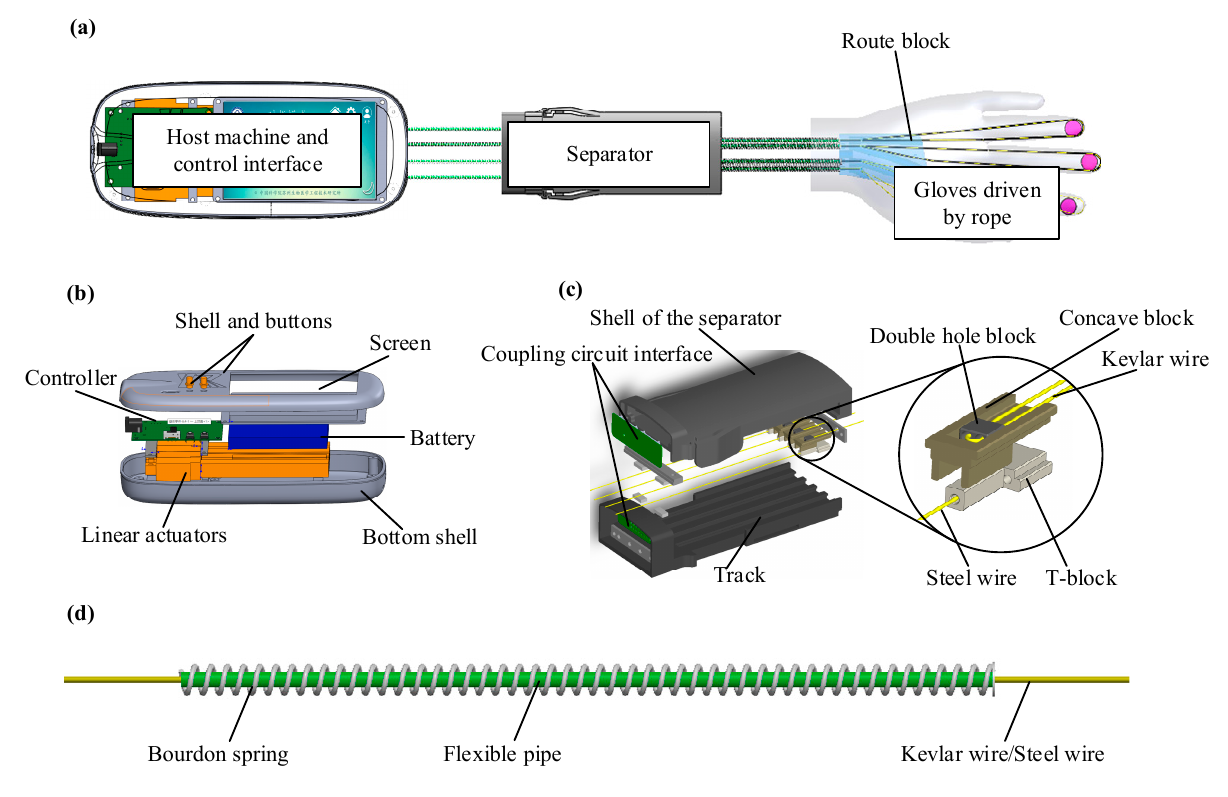
Figure 3. Structure diagram of hand functional rehabilitation robot. ( a ) Overall structure diagram of hand rehabilitation robot [34–36]; ( b ) Control host; ( c ) Separation transmission platform; ( d ) Lasso transmission